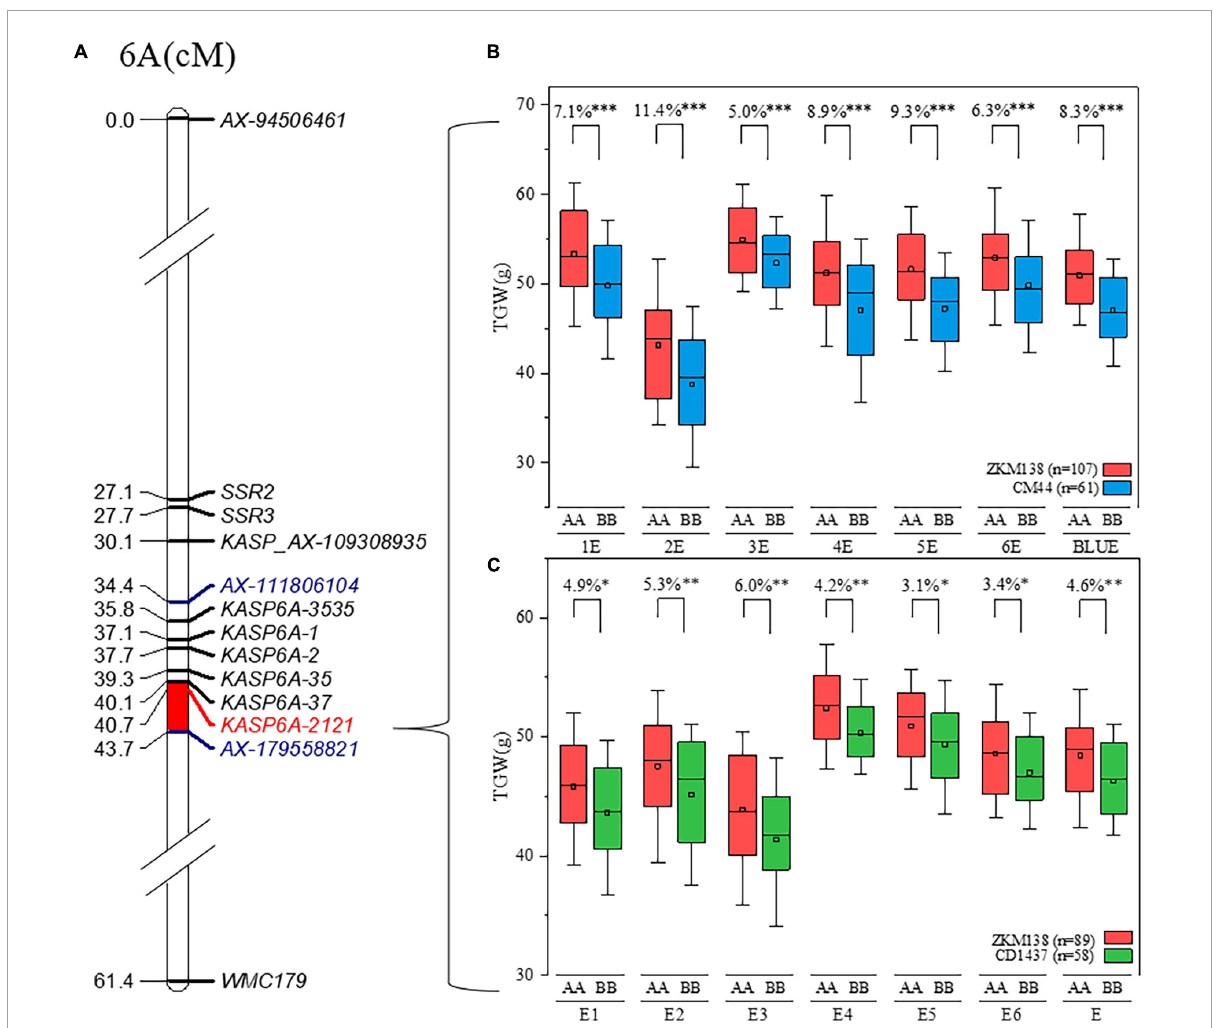
FIGURE4 Delimitation and validation of QTgw.cib-6A . (A) The new integrated genetic map of QTgw.cib-6A ; markers in blue represent the preliminary QTL interval of QTgw.cib-6A ; markers in red represent tightly linked marker; and the bar in red represents the new interval of QTgw.cib-6A based on the integrated genetic map. (B) Effect estimation of QTgw.cib-6A on TGW in the BC population; the red and blue boxes indicate the TGW (g) performance of the lines with alleles from ZKM138 and CM44, respectively; ∗ , ∗∗ , and ∗∗ represent significance at P < 0.05, P < 0.01, and P < 0.001, respectively. (C) Effect estimation of QTgw.cib-6A on TGW in the ZC population. The red and green boxes indicate the TGW (g) performance of the lines with alleles from ZKM138 and CD1437, respectively; ∗ , ∗∗ , and ∗∗∗ represent significance at P < 0.05, P < 0.01, and P < 0.001,